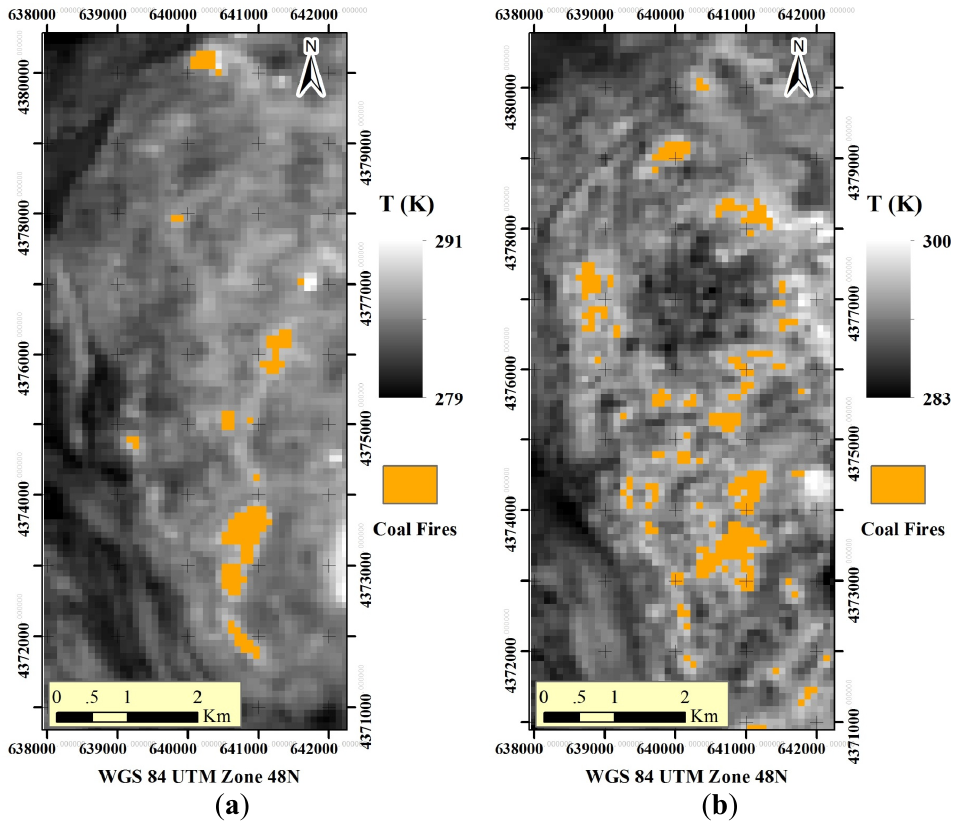
Figure 15. Coal fire areas retrieved from ( a ) nighttime images for 21 September 2002 and ( b ) daytime image for 26 March 2010. Coal fires were compared with results from